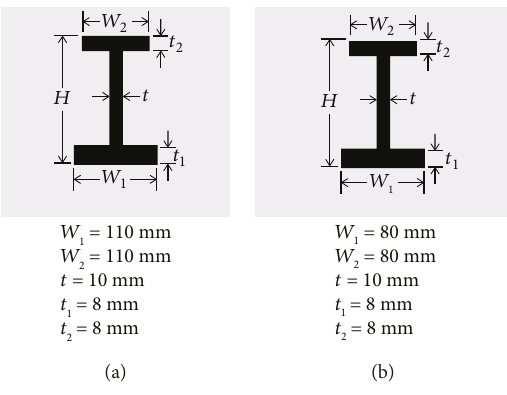
Figure 3: The size of fore beam and the rear